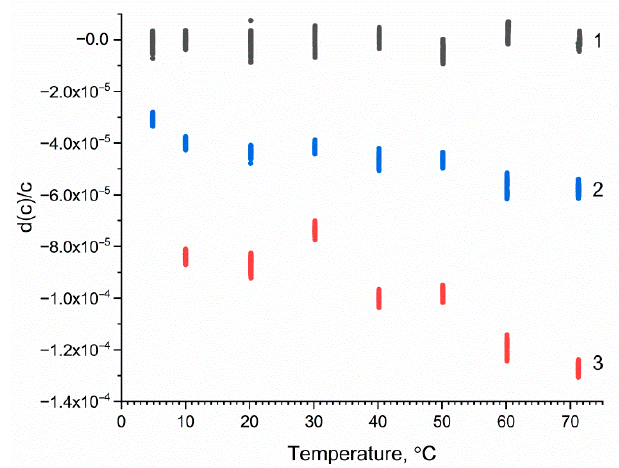
Figure 4. Dependence of the relative velocity of ultrasound in water on temperature at various concentrations of deuterium oxide. (1) Light water (without deuterium oxide), (2) 50% light water and 50% ordinary water (with a natural amount of deuterium oxide), and (3) ordinary water. There was light water in the reference cell. The ordinary water is deionized distilled tap water. c is the velocity of ultrasound in the reference cell; d(c) is the difference of the velocity of ultrasound in the sample cell and in the reference cell.